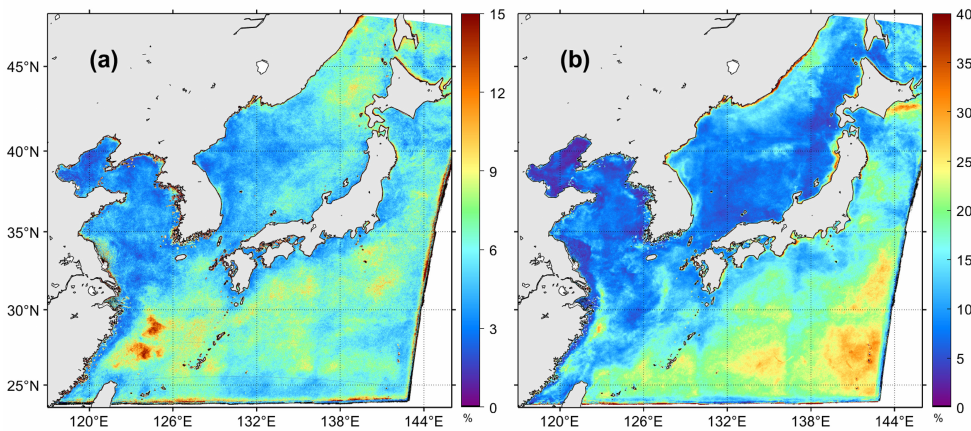
Figure 10. Spatial distribution of appearances frequency of ( a ) high- and ( b ) low-value erroneous pixels in 2015.